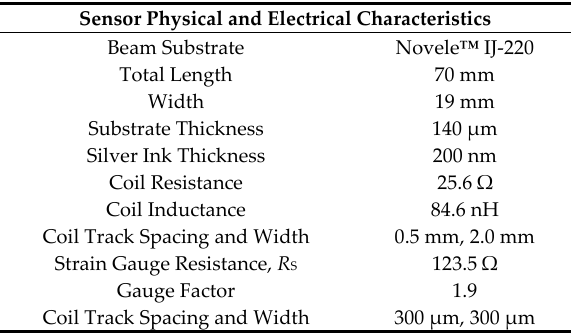
Figure 1. ( a ) Layout of the inkjet-printed sensor; ( b ) Clamping system for wiring the printed sensor. Table 1. Sensor